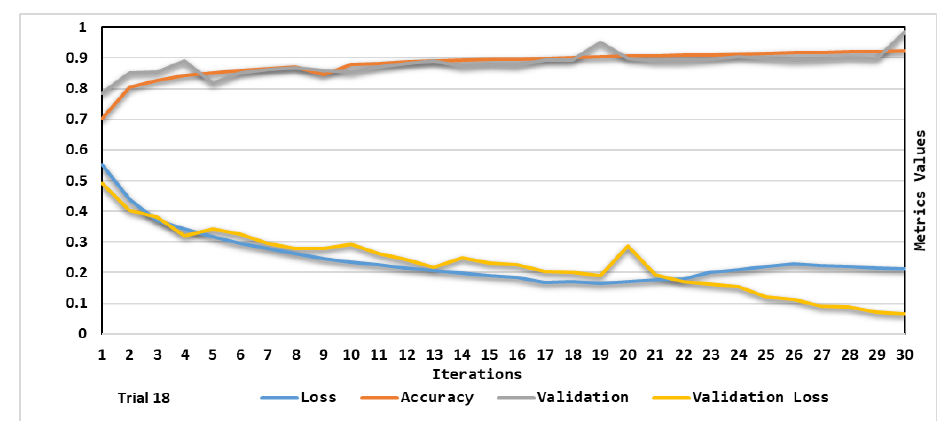
Fig. 7. Using DenseNet121 model in trial 18.